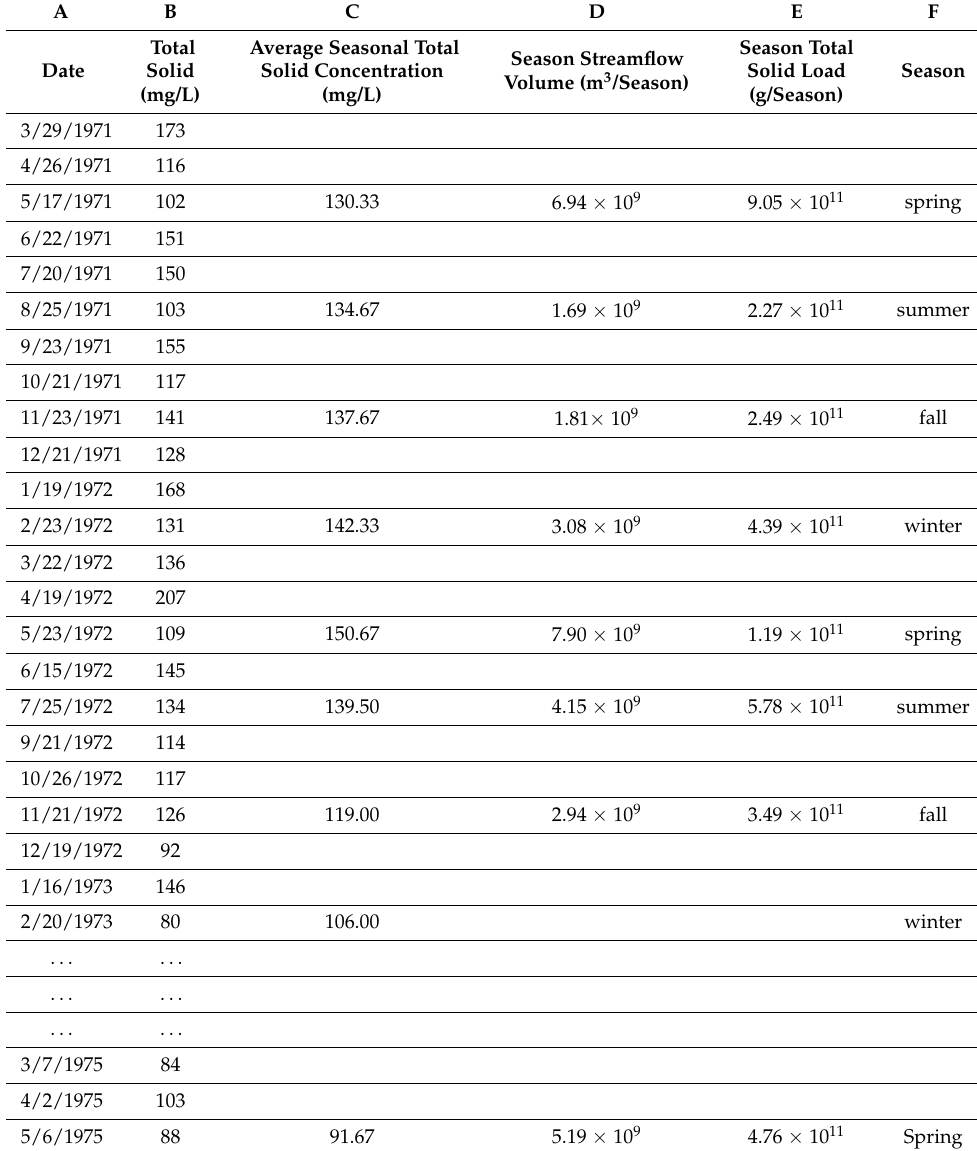
Table 2. Some measured seasonal sediment load calculations for Station